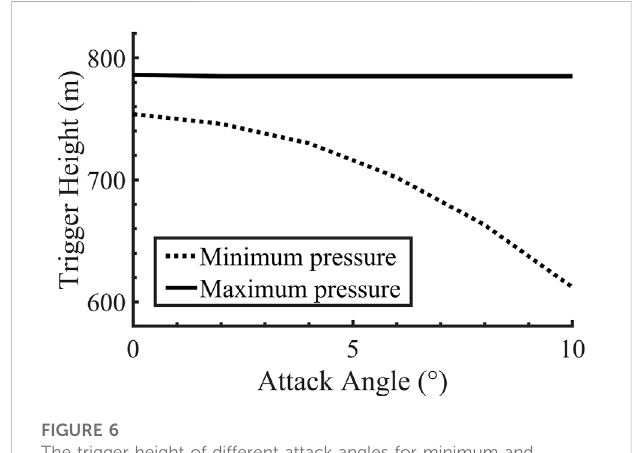
FIGURE 6 The trigger height of different attack angles for minimum and maximum air pressure